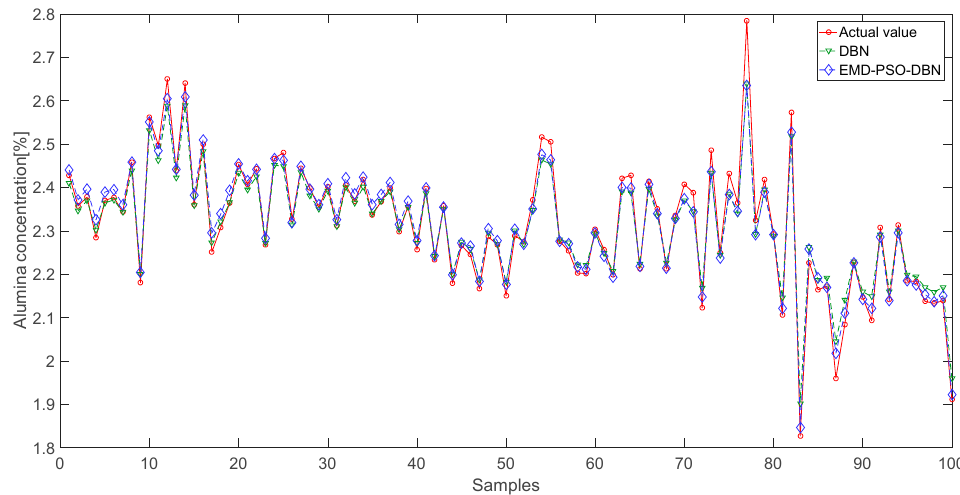
Figure 13. Comparison of prediction and actual value of soft-sensing model for the alumina concen- tration.